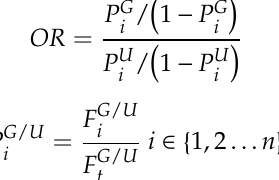
Table S1: Up and down-regulated genes in pre-symptomatic HD, Table S2: Up and down-regulated genes in symptomatic HD, Table S3: Description of some over and under-expressed genes in pre-symptomatic and symptomatic HD, Table S4: DyNet re-wiring between pre-symptomatic and symptomatic, Table S5: Gene Ontology (GO) biological pathways for rewired and DEGs pre-symptomatic HD, Table S6: GO biological pathways for rewired and DEGs symptomatic HD, Table S7: Pathways related to pre-symptomatic HD, Table S8: Pathways related to symptomatic HD, Table S9: OR analysis pathways for pre-symptomatic and symptomatic HD, Table S10: OR analysis pathways for pre-symptomatic HD, Table S11: OR analysis pathways for symptomatic HD, Table